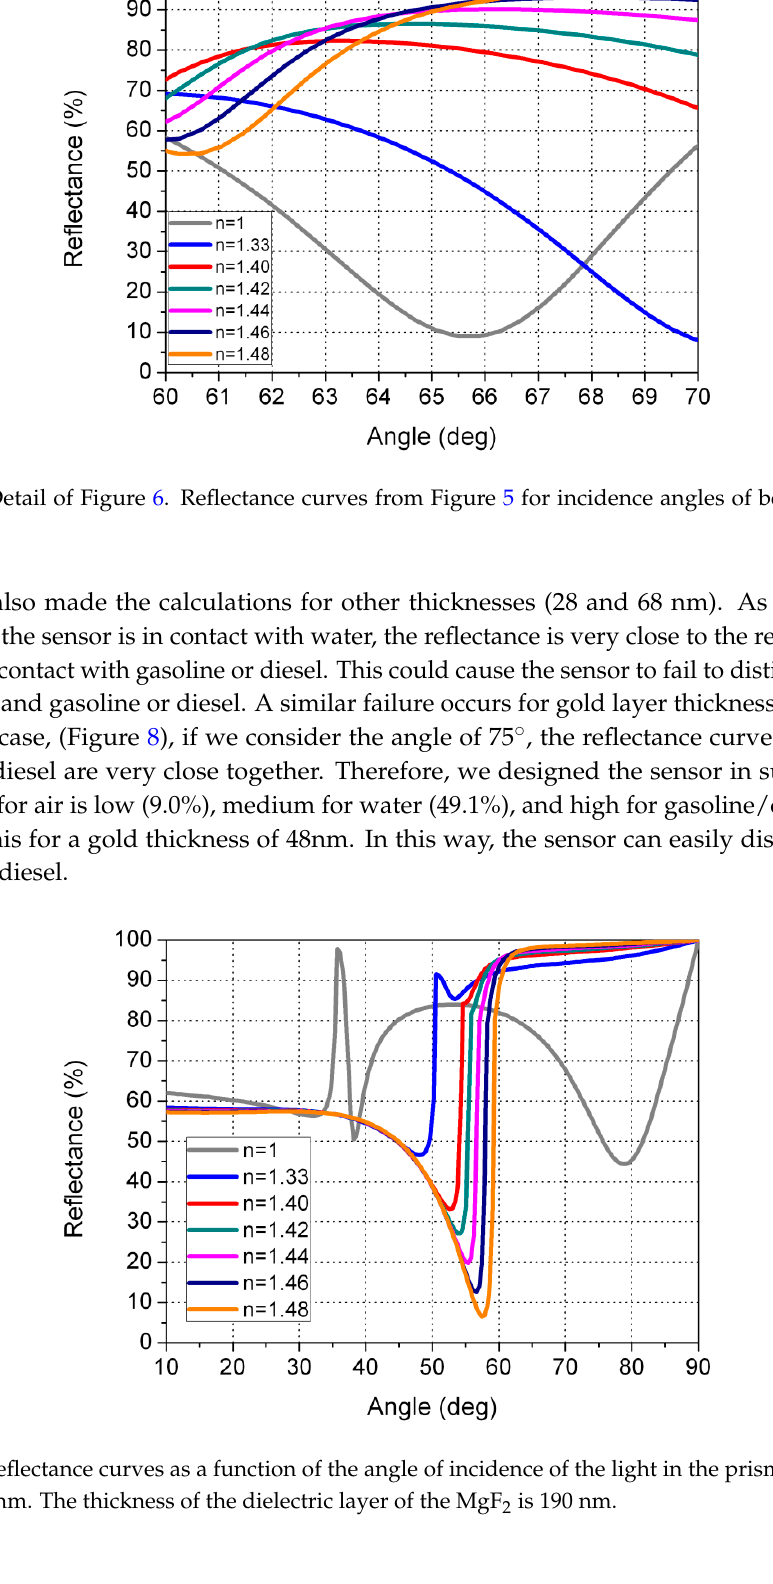
Figure 5. Reflectance curves as a function of the angle of incidence of the light in the prism. These represent the curves when the sensor is in contact with air (cid:4666)(cid:1866) = 1(cid:4667) , water (cid:4666)(cid:1866) = 1.33(cid:4667) , and gasoline or diesel fuel (cid:4666)(cid:1866) = 1.40 − 1.48(cid:4667) . The thickness of the gold layer is 48 nm, and the thickness of dielectric layer of the MgF 2 is 190 nm.